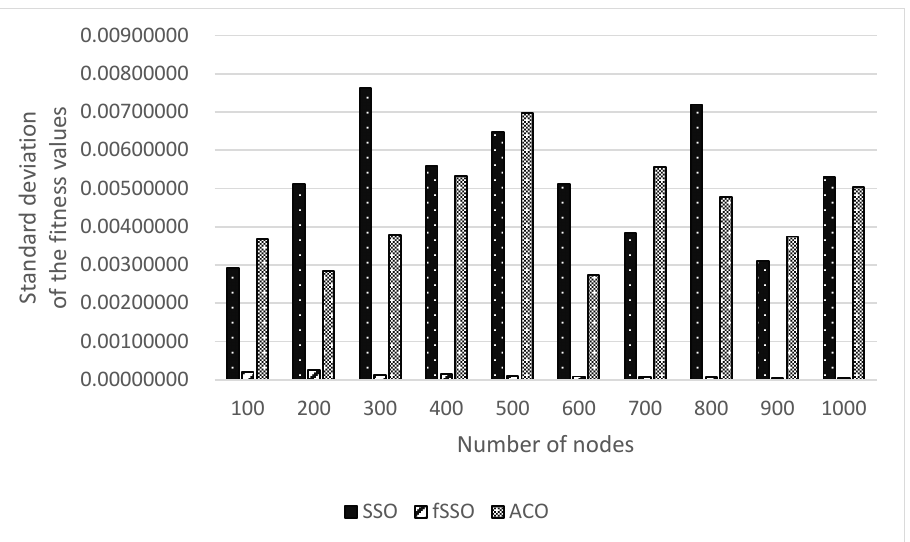
Figure 9. Average of the fitness values for ten benchmarks.